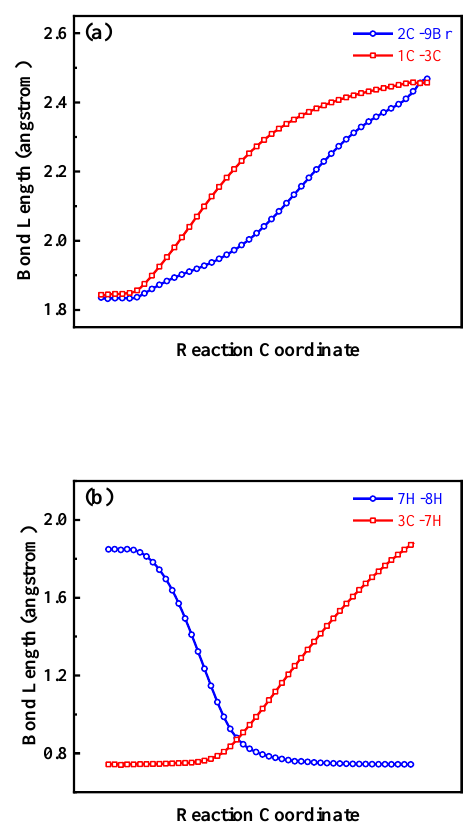
Figure 5. ( a ) The variations of 2C-9Br (blue circle) and 1C–3C (red square) bond length of single charged molecular ion alone the channel (1), ( b ) The variations of 7H–8H (blue circle) and 3C–7H (red square) bond length of single charged molecular ion alone the channel (2) in Figure (4), respectively.